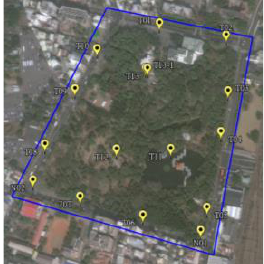
Figure 9 Distribution of GCP in control fields